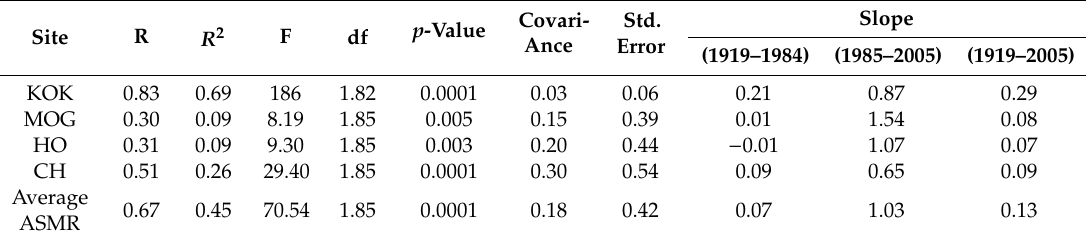
Table 3. Statistical parameters of iWUE the iWUE chronologies from Koksu (KOK), Mongun (MOG), Ersin (HO), Chadan (CH) and averaged iWUE calculated for all studied sits for the Altai-Sayan Mountain Range (ASMR) for the common period from 1919 to